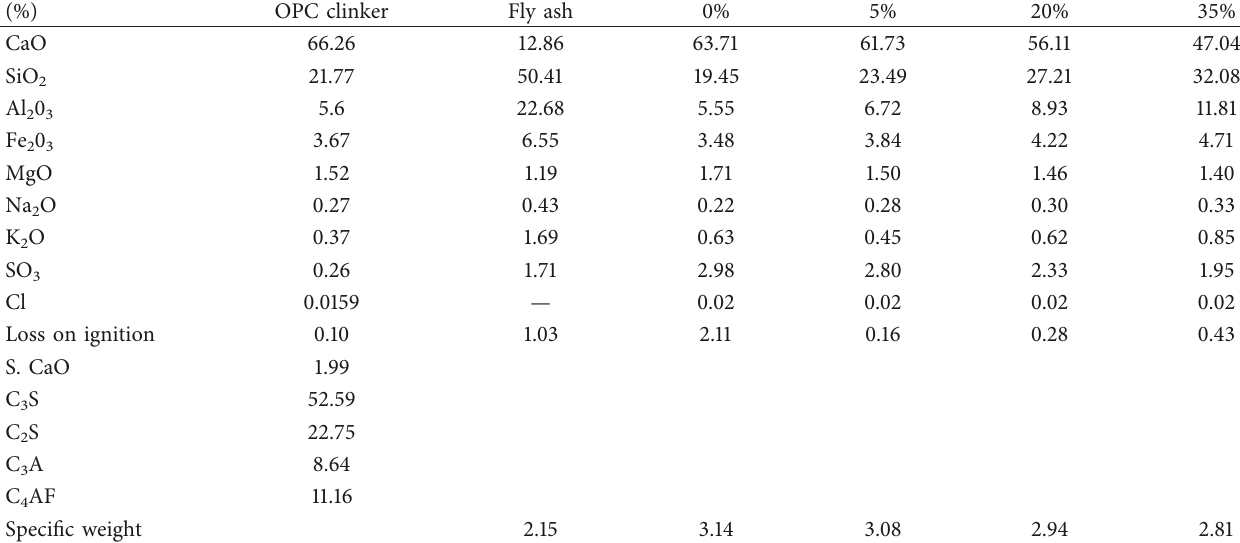
Table 1: The chemical properties of clinker, fly ash, and cement.